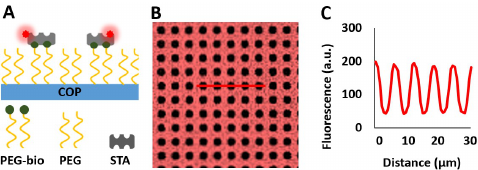
Figure 1. Determination of pattern contrast and biomolecule density on micropatterned substrates using fluorescence microscopy. ( A ) Schematic overview of fluorescently labeled streptavidin bound to the micropatterned cyclic olefin polymer (COP) surface. ( B ) Fluorescence image (image size: 65 × 65 µ m) and ( C ) the corresponding line profile.